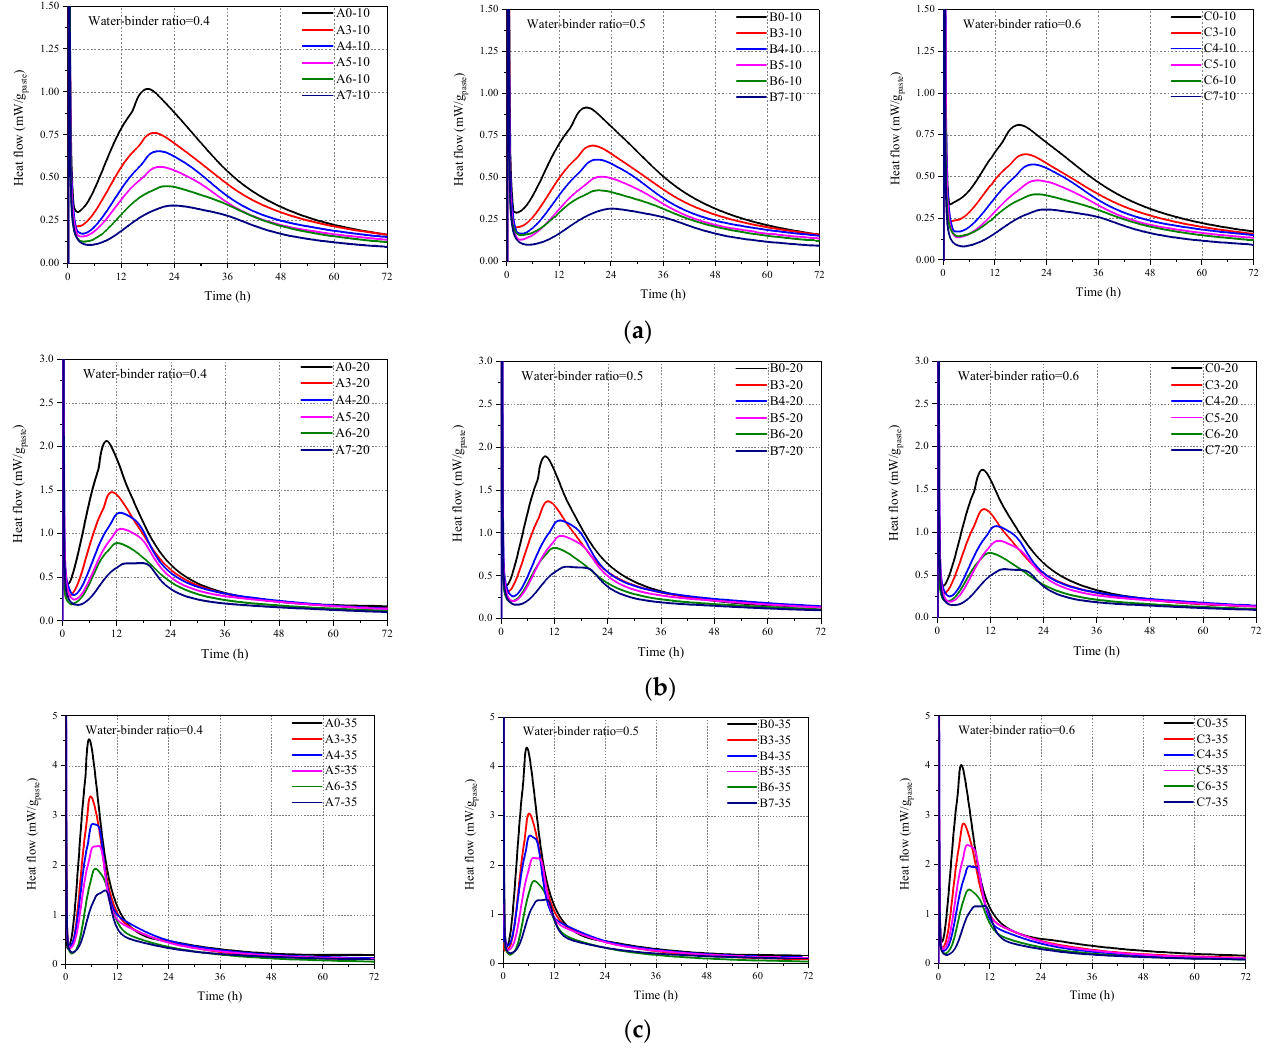
Figure 3. Heat flow of cement pastes at different temperatures. ( a ) heat flow of the cement paste at 10 °C; ( b ) heat flow of the cement paste at 20 °C; ( c ) heat flow of the cement paste at 35 °C.